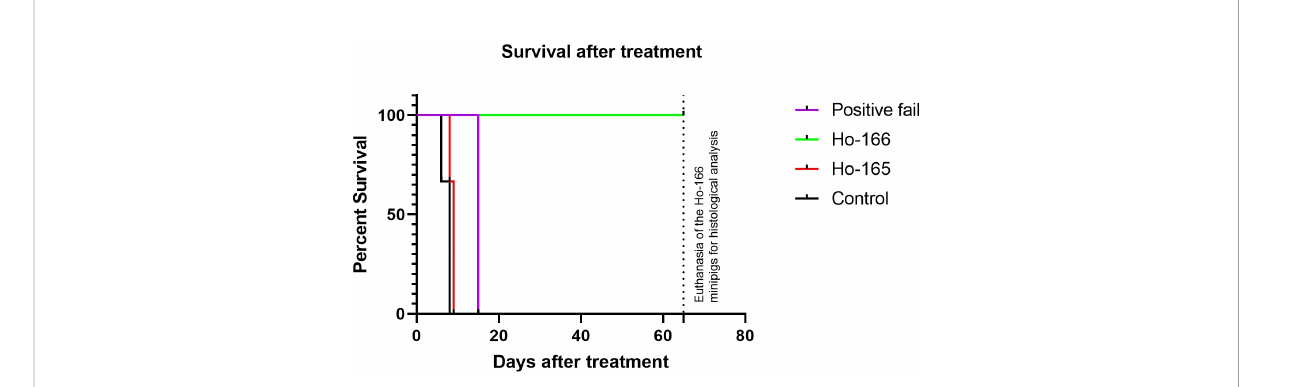
FIGURE 3 Kaplan-Meier survival curves of group 1 ( 166 Ho), group 2 ( 165 Ho), the control group and the “ positive fail pig ” .